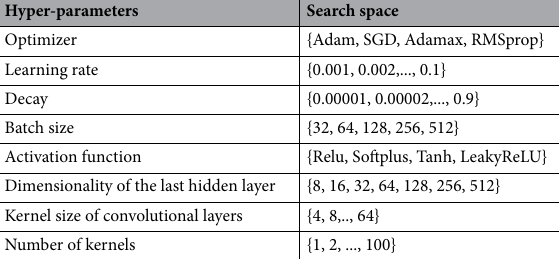
Table 1. Search space of NNI.